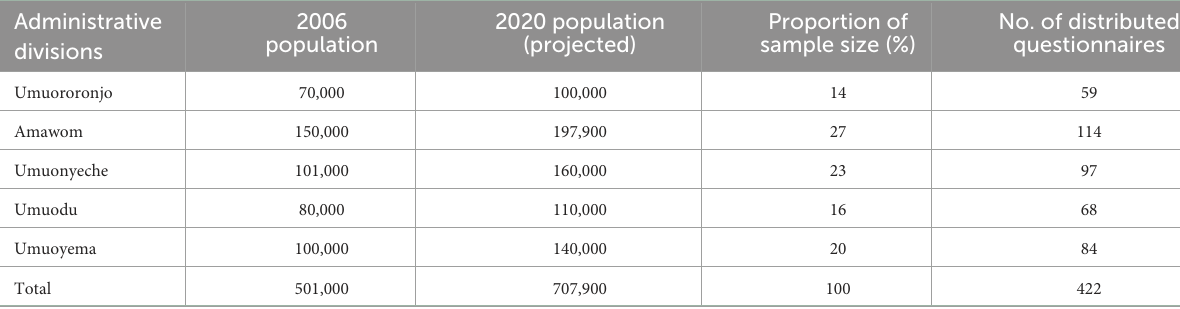
TABLE 1 Determination of sample